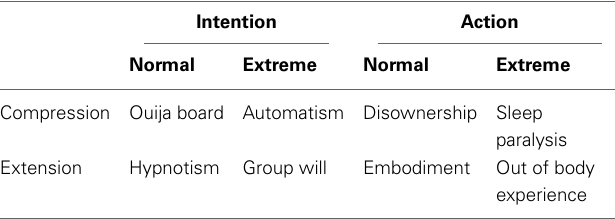
Table 3 | Experimental paradigms derived from our